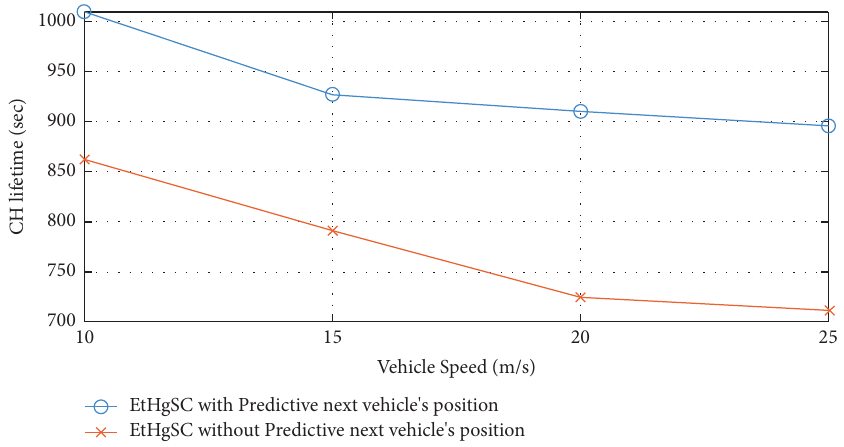
Figure 6: CH lifetimes for EtHgSC with and without predicted next vehicle’s position.